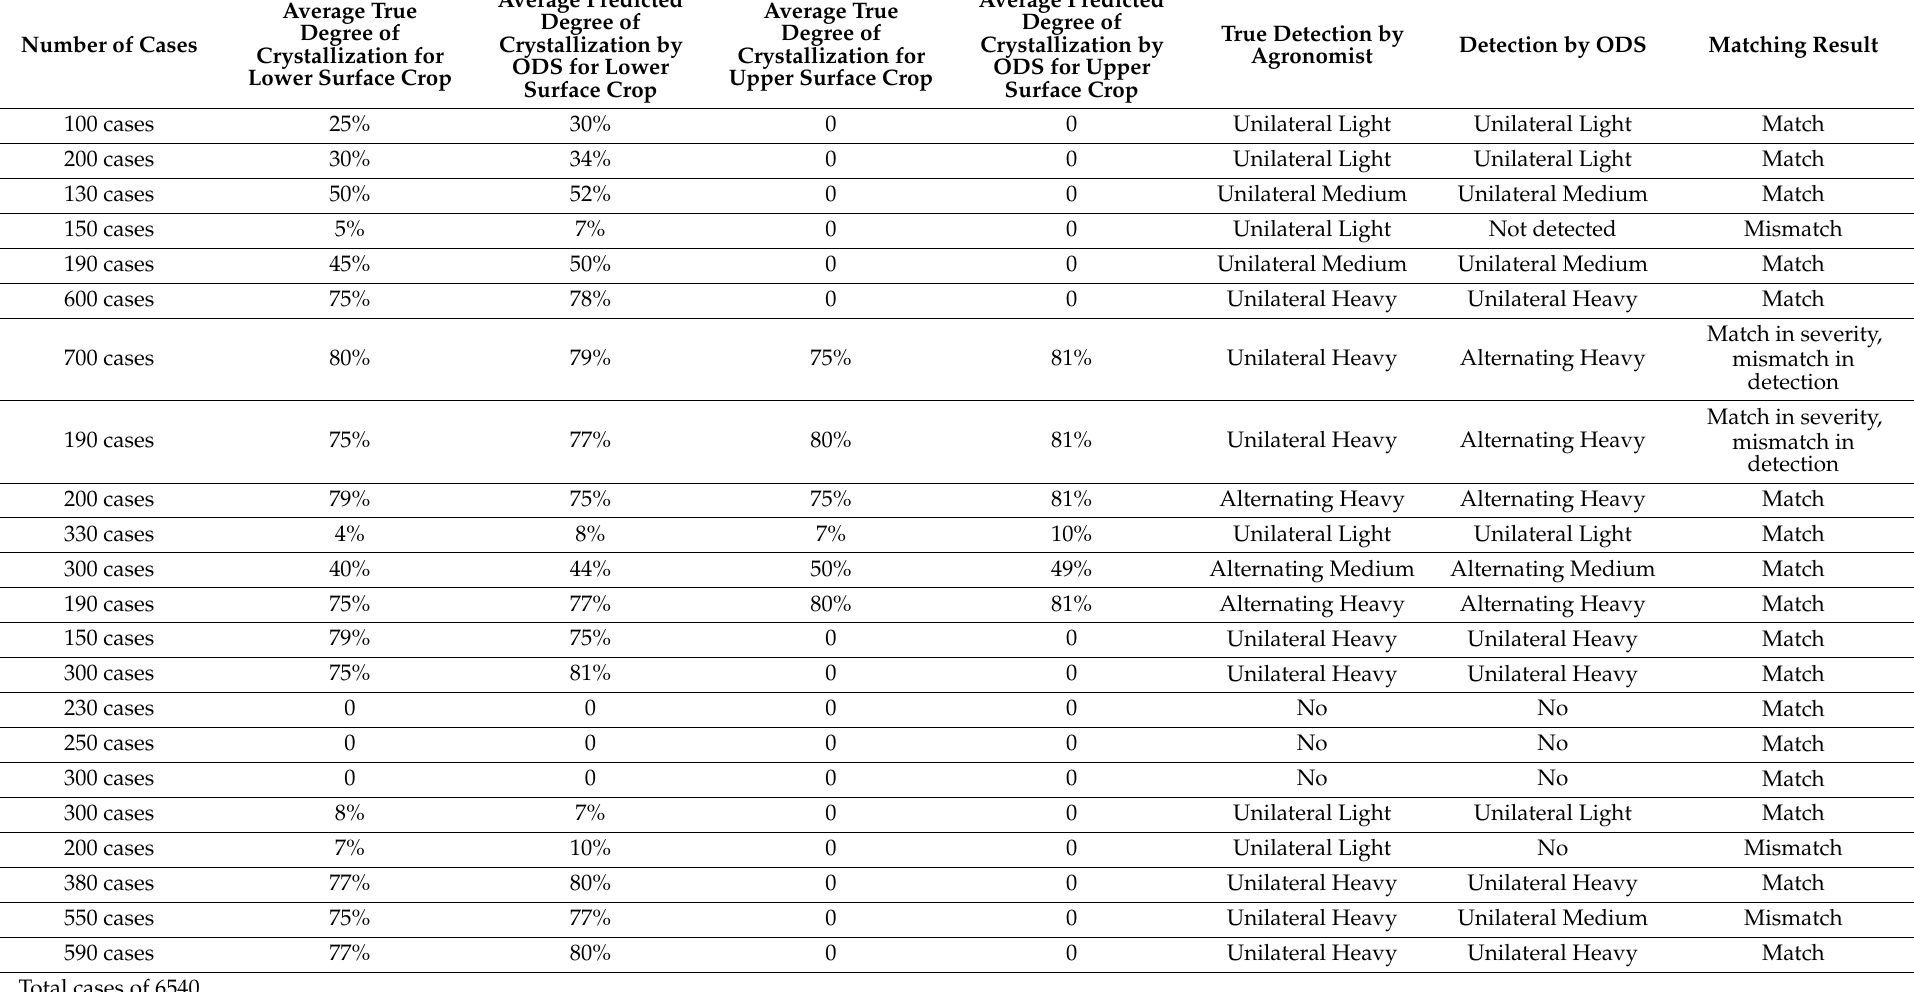
Table 5. ODS experimental results versus actual agronomist detection